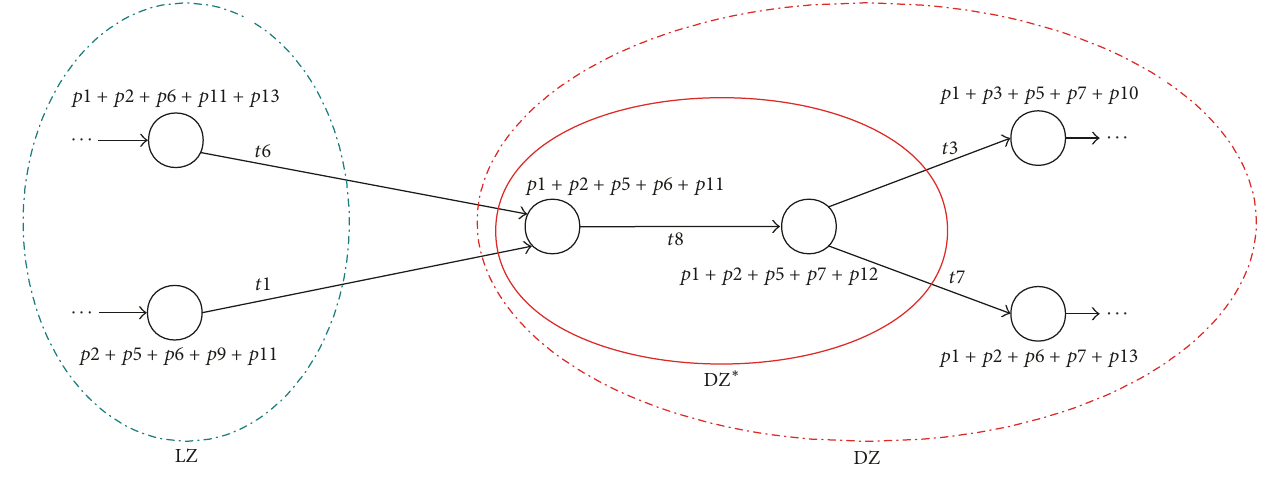
Figure 4: Simulation results in Figure 3 in the case of 𝑀 0 (𝑝 10 ) = 𝑀 0 (𝑝 11 ) = 1 .